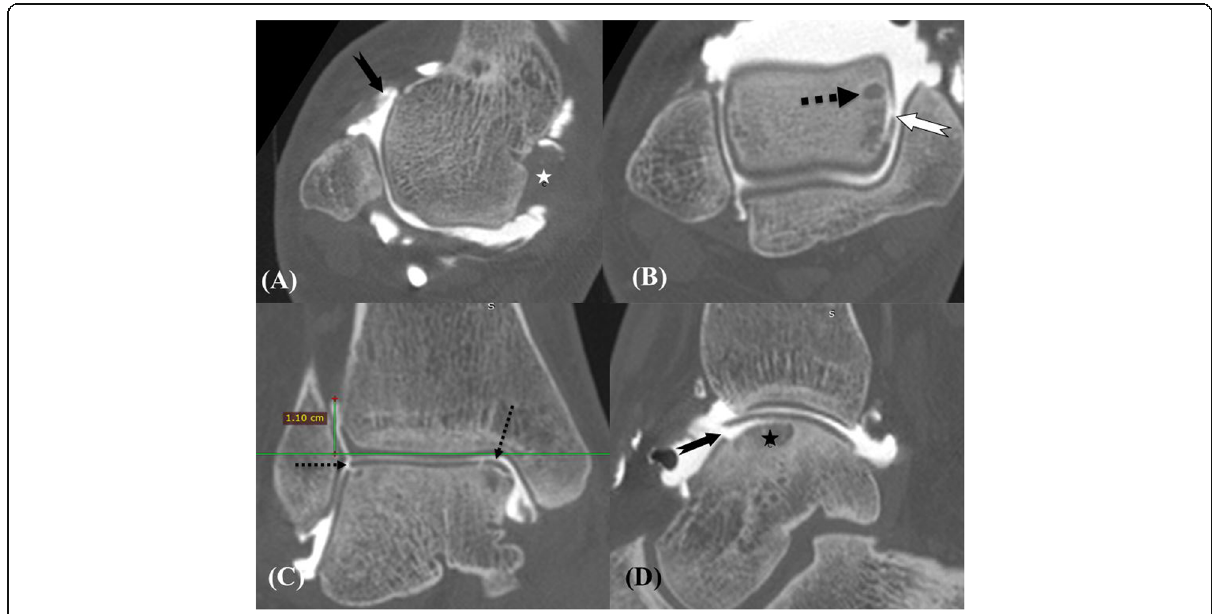
Fig. 1 Right chronic diffuse ankle pain following prior lateral sprain. Axial CTA images through the talus at the level of the talar neck ( a ) and at the talar dome ( b ) demonstrate ATFL tear at its talar insertion (black arrow) along with irregular proximal fibers, note normal deep deltoid ligament (star). At the talar dome, there is an extensive OCL with cystic changes (dashed arrow) and delamination of the cartilage (white arrow).